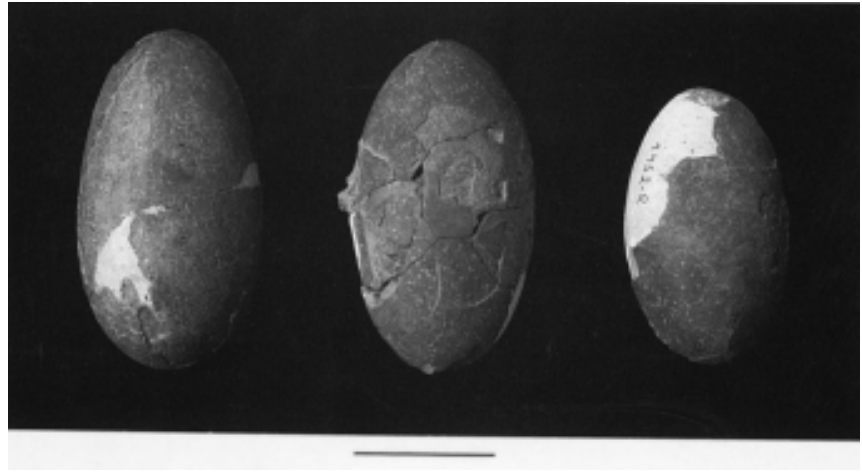
Fig. 21 – Three theropod dinosaur eggs, from the Late Cretaceous strata of the Uberaba Formation, Minas